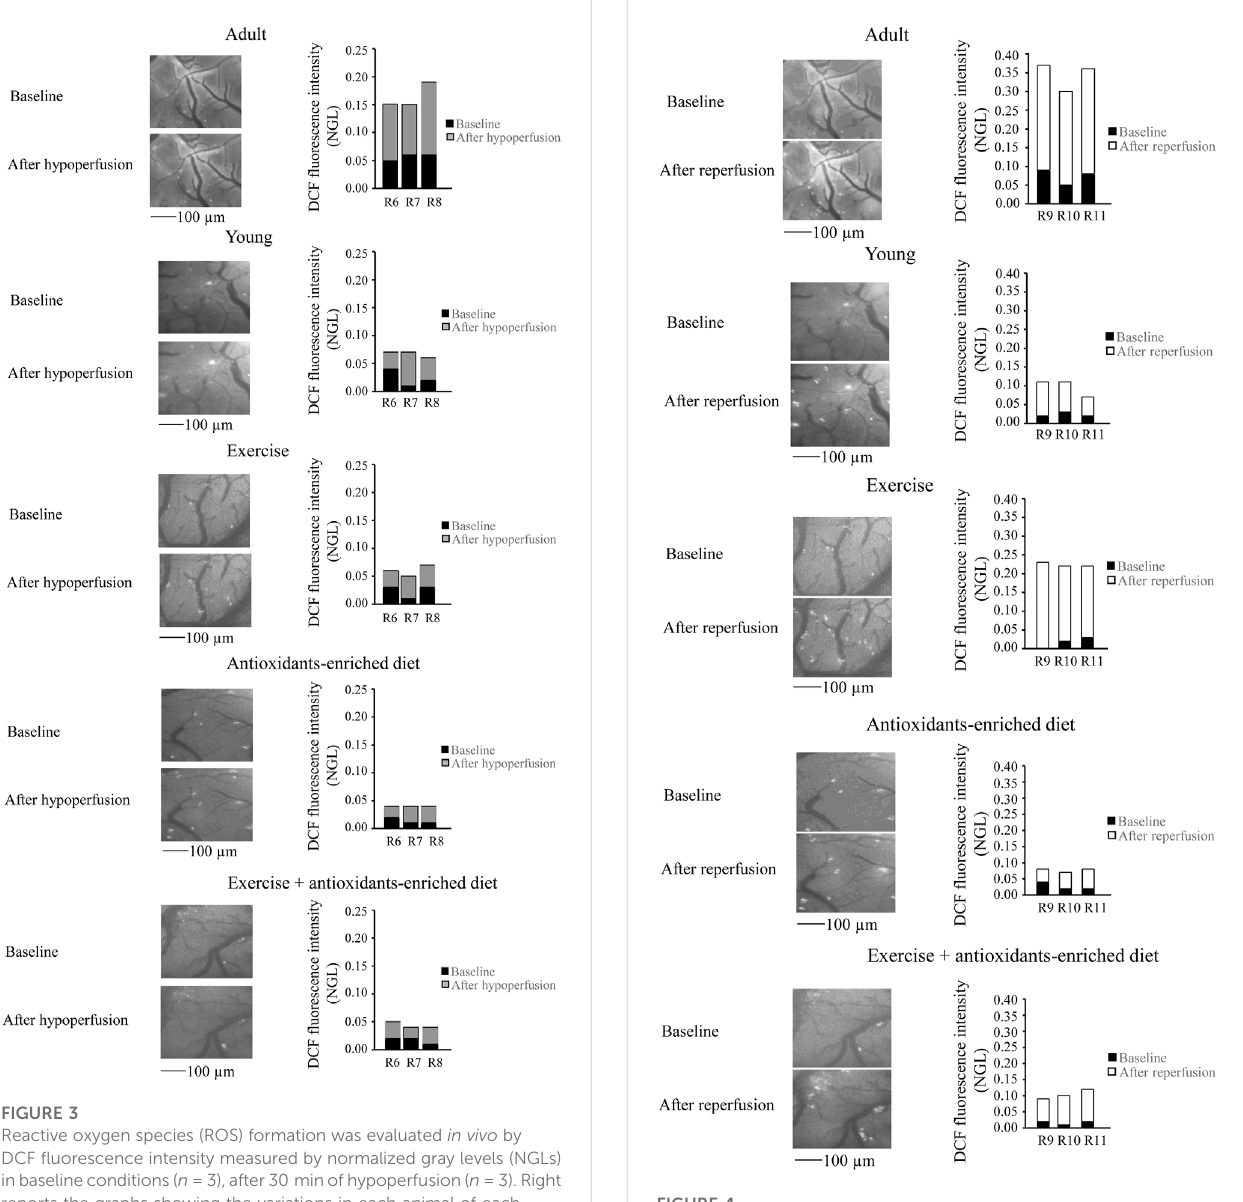
FIGURE 4 Reactive oxygen species (ROS) formation was evaluated in vivo by DCF fl uorescence intensity measured by normalized gray levels (NGL) in baseline conditions ( n = 3) and after 60 min of reperfusion ( n = 3) in the different experimental groups. Right reports the graphs showing the variations in each animal of each experimental group (R9 – R11). Left reports the corresponding video images of the pial microcirculation obtained with a fl uorescencemicroscopeinaSHR ratbelongingto each experimental Antioxidants-enriched diet-treated SHRs (AED group) were protected from fl uorescent leakage under baseline conditions, as observed in young SHRs (NGL: .04 ± .01, p < .01 vs. A group). At the end of BCCAO, NGL were .05 ± .01 ( p < .01 vs. A, Y, and E groups) while after reperfusion, there was an increase: (NGL: .28 ± .0), lower compared with the other experimental groups ( p < .01 vs. baseline, A and E groups) (Figure 2). Under baseline conditions, physical exercise plus antioxidants- enriched diet-treated SHRs (E + AED group) showed a slight increase